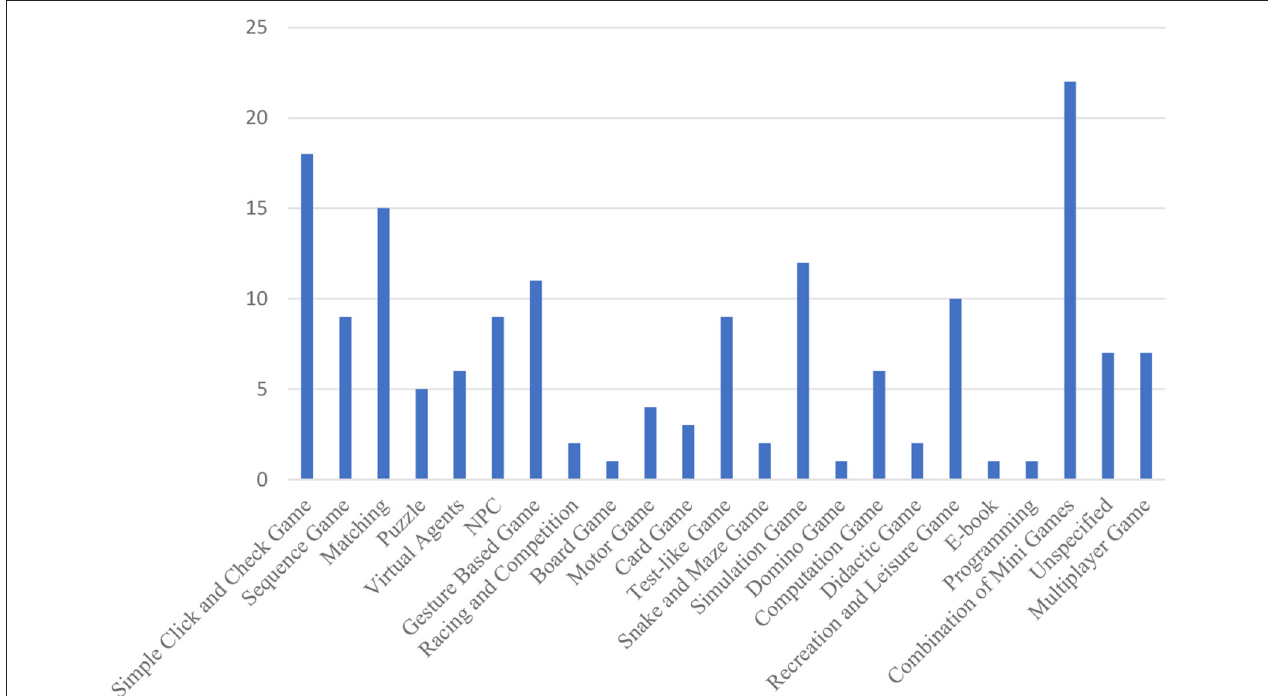
FIGURE 7 | Distribution of game